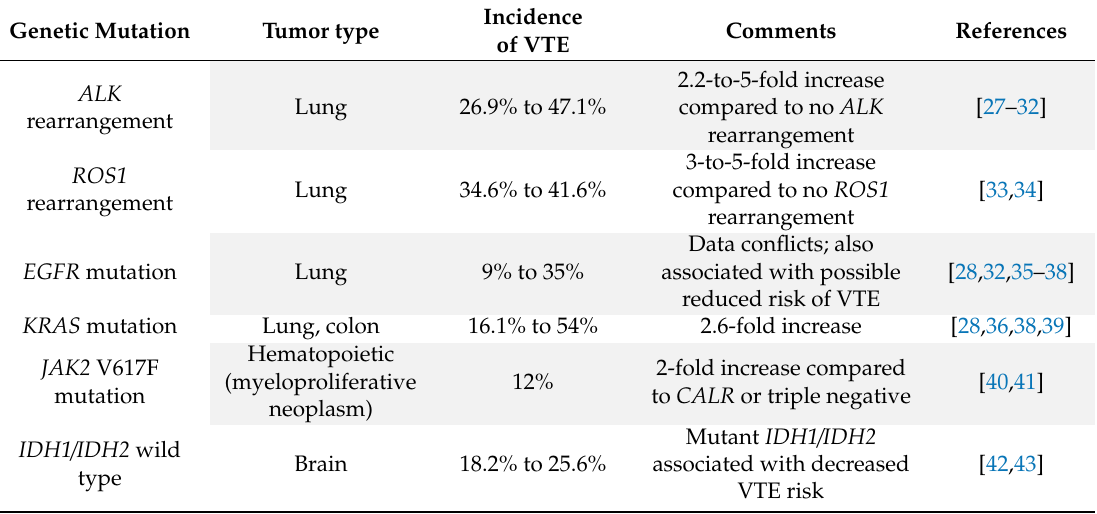
Table 2. Molecular aberrations associated with increased thromboembolic